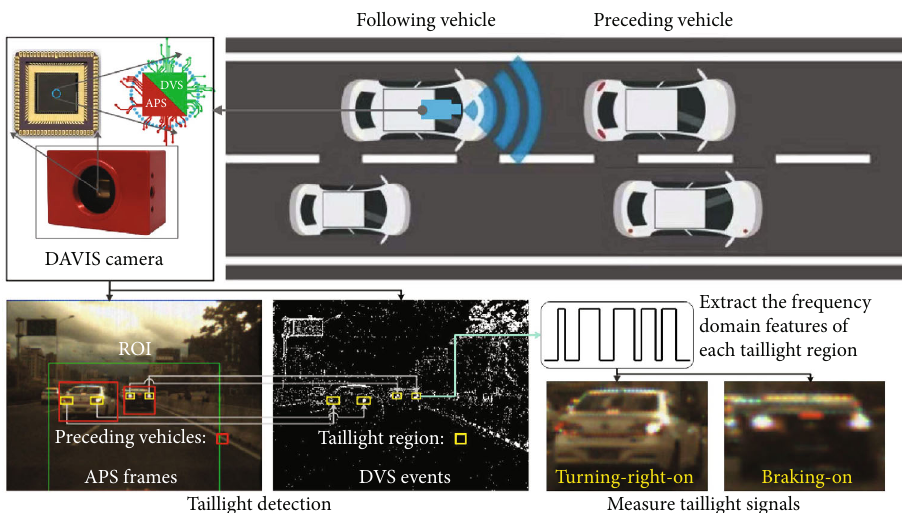
Figure 2: Illustration of the taillight signal measurement